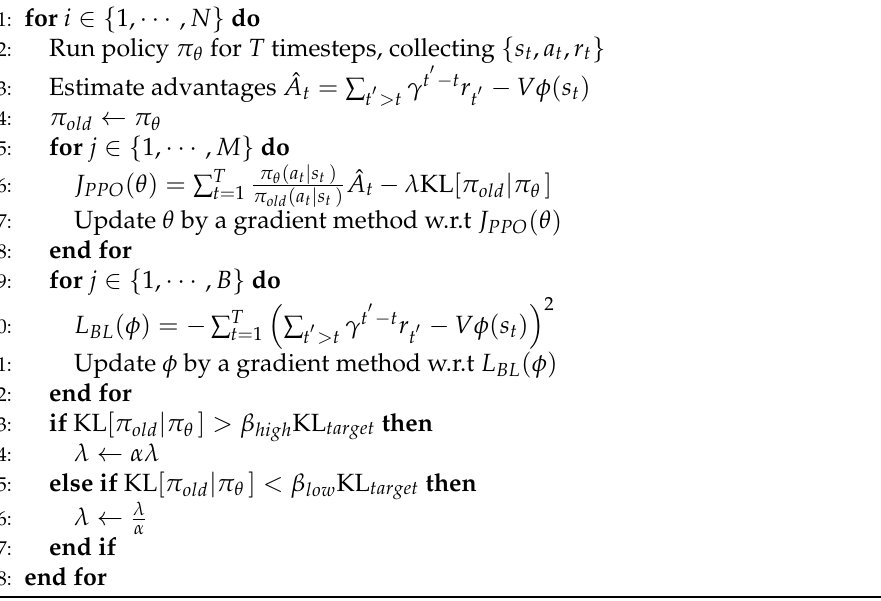
Algorithm 3 Proximal Policy Optimization Algorithm (adapted from [32])